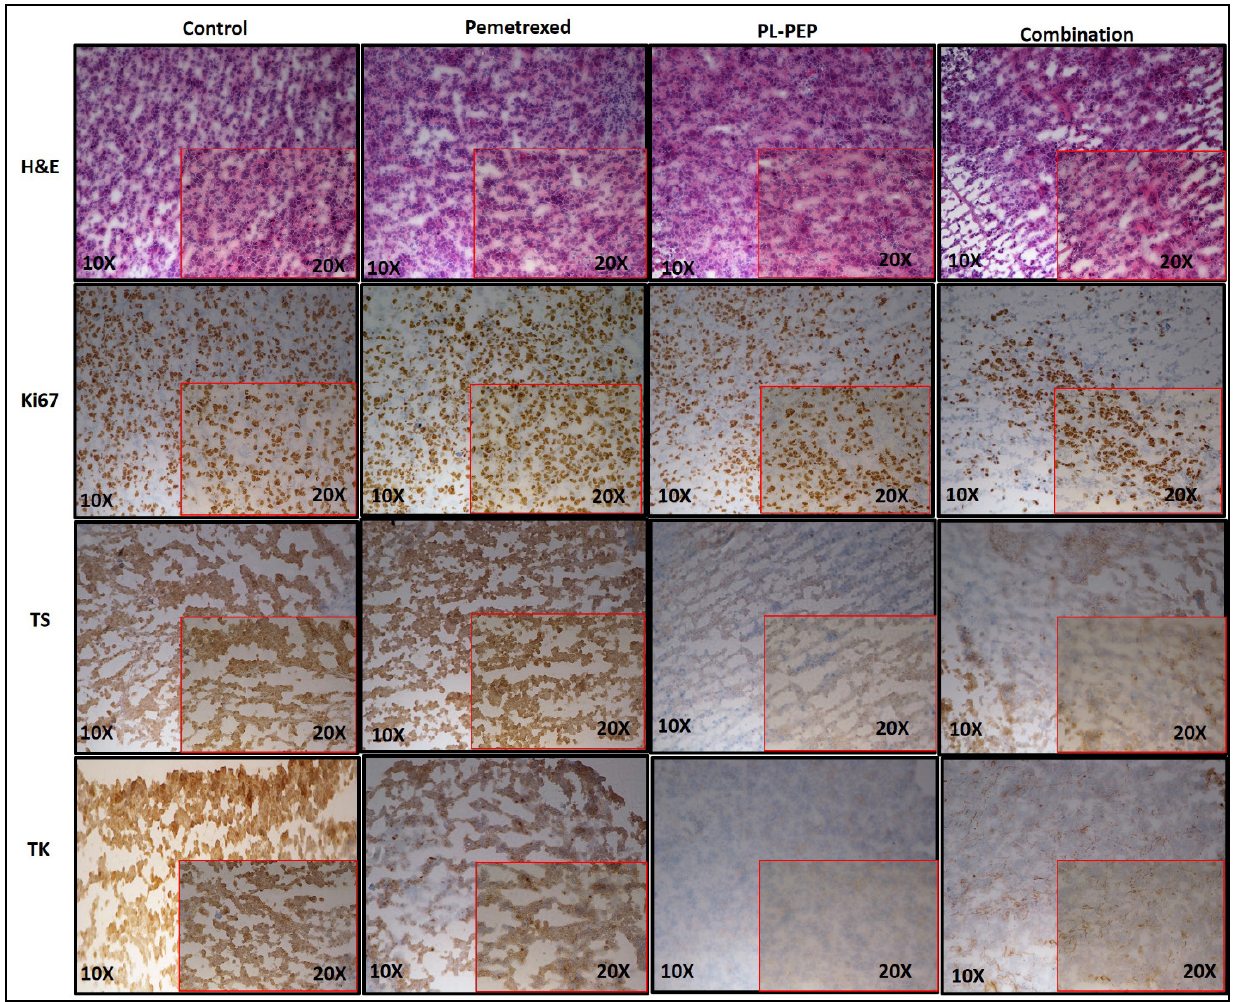
Figure 8. Immunohistochemistry (IHC) staining of H2009 tumors extracted from mice 7 days following the last dose of drug treatment in Figure 7 against various biomarkers. Ki67 staining showing proliferation; TS (thymidylate synthase) and TK (thymidine kKinase) are key enzymes involved in DNA synthesis. Tonsil tissue was used as a positive control for IHC staining.